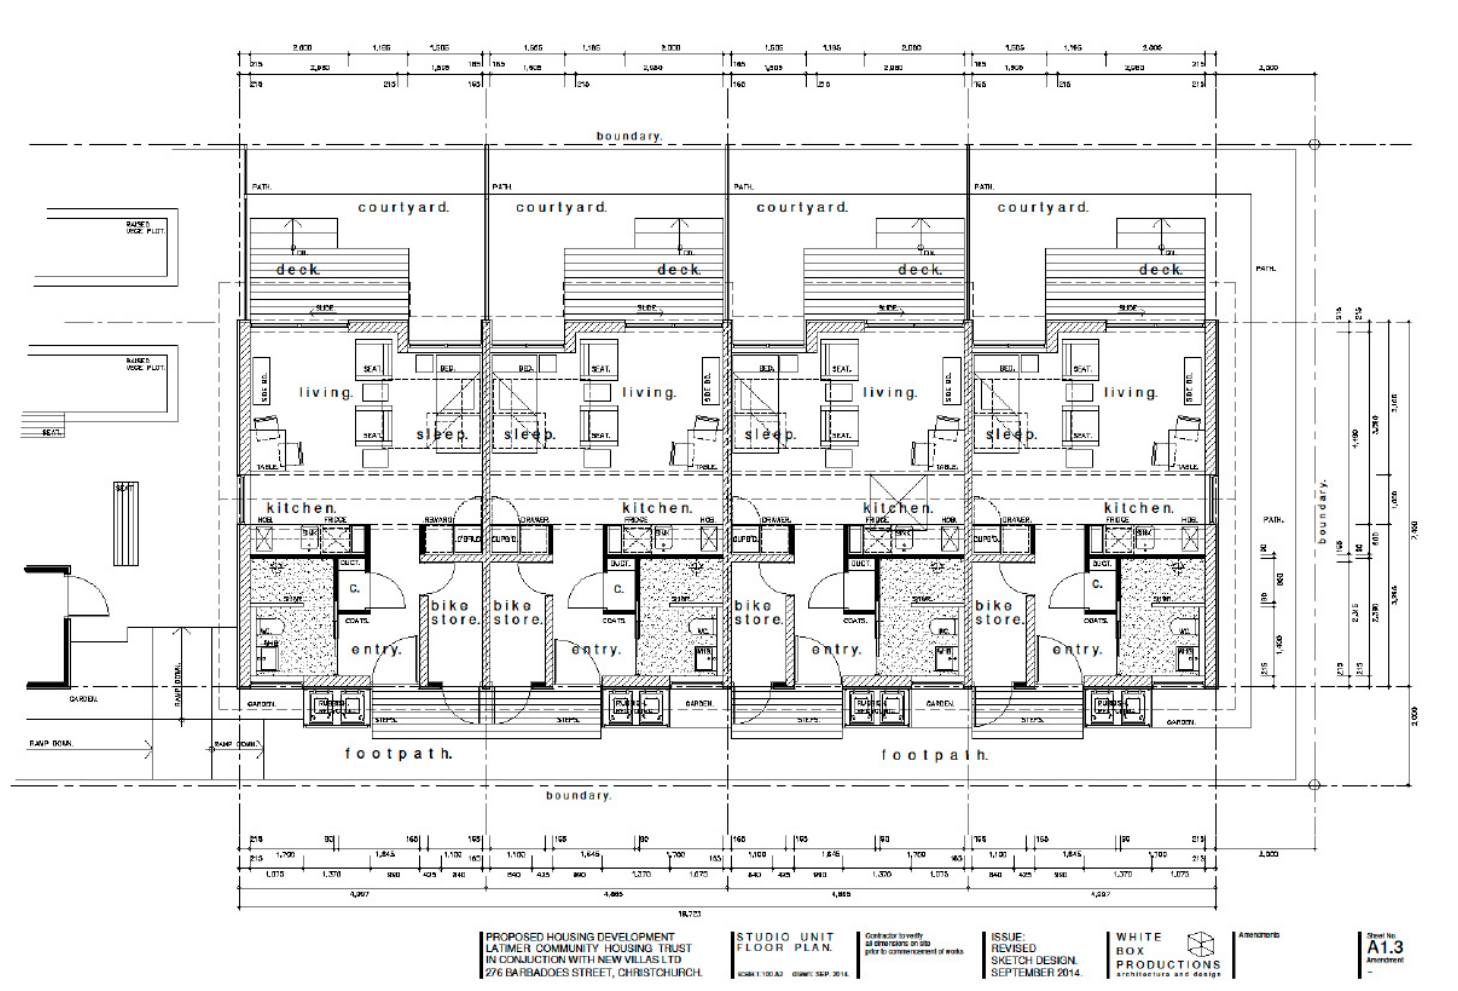
Figure 2. Plan of the model lightweight building B (studio-unit house).